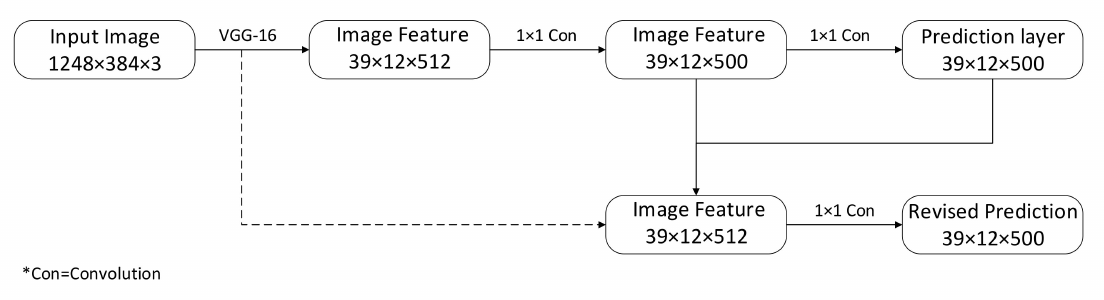
Figure 7. The proposed structure. VGG: visual geometry